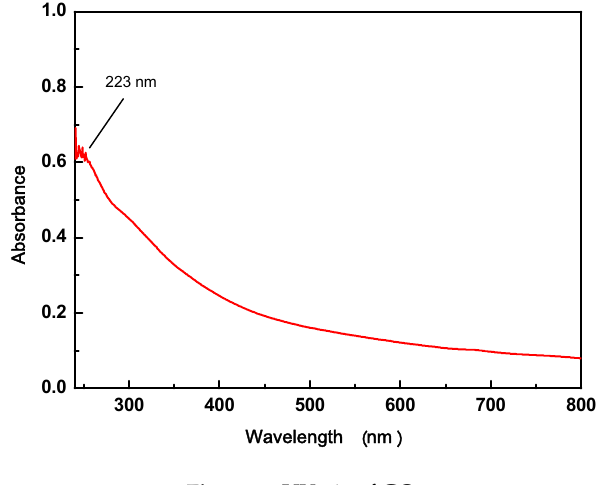
Figure 2. UV-vis of GO. Figure 2. UV-vis of